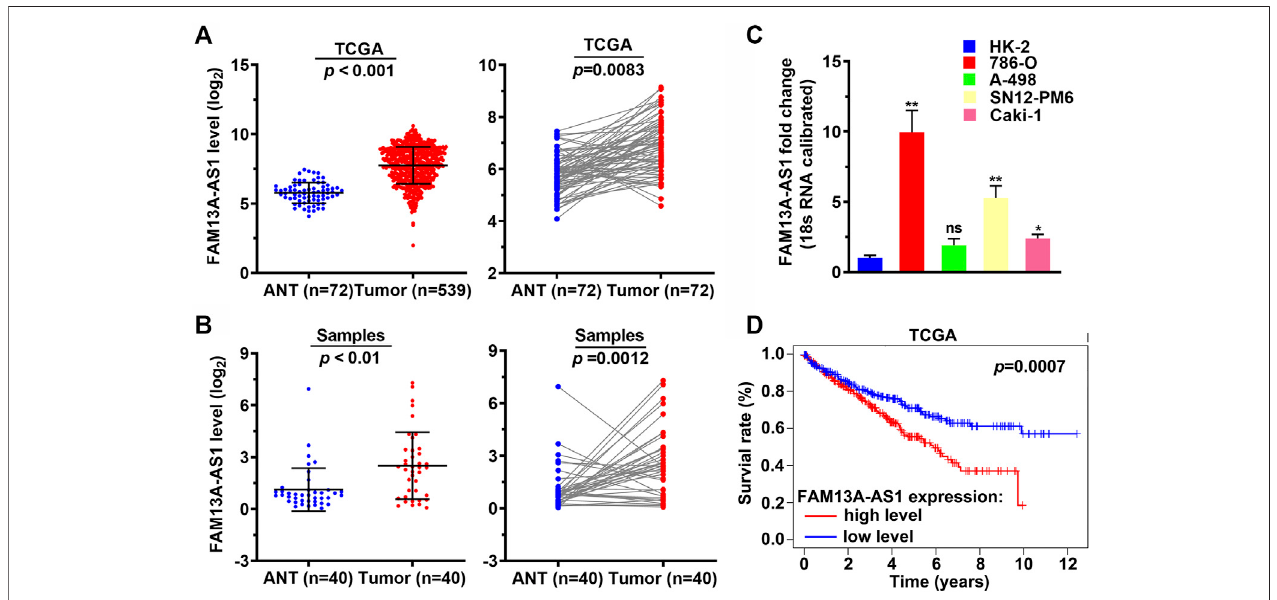
FIGURE 1 | FAM13A-AS1 is upregulated in RCC and associated with poor clinical outcome. (A) Scatter plots showing the expression levels of FAM13A-AS1 in RCC( n =539)andnormaltissues( n =72)fromTCGAcohort. (B) ScatterplotsshowingtheexpressionlevelsofFAM13A-AS1inRCC( n =40)andnormaltissues( n =40) from our cohort. (C) Bar plot showing the fold change in FAM13A-AS1 expression in human kidney epithelia and cancer cell lines. (D) Kaplan-Meier analysis of overall survival of 515 RCC patients in TCGA-KIRC strati fi ed by high and low FAM13A-AS1